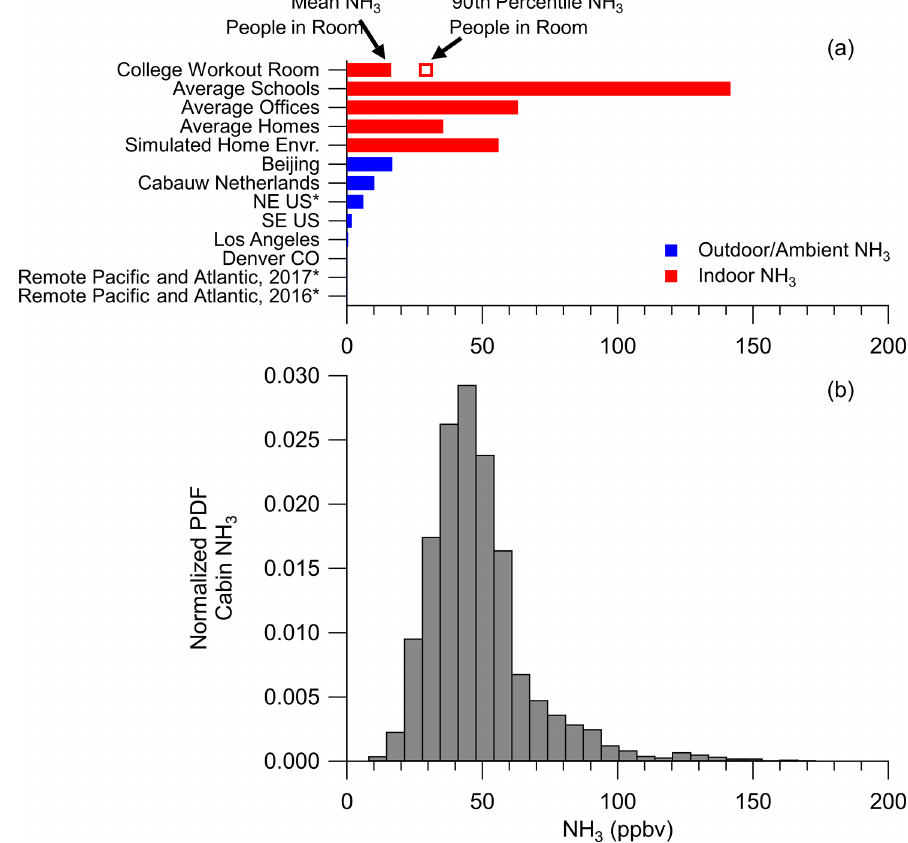
Figure 6. (a) Ammonia (NH 3 ) (ppbv) reported for various studies. See Table S1 for references. An asterisk after the study name indicates NH 3 predicted by a thermodynamic model instead of being measured. (b) Normalized probability distribution function (PDF) for NH 3 measured in the cabin of the NASA DC-8 during